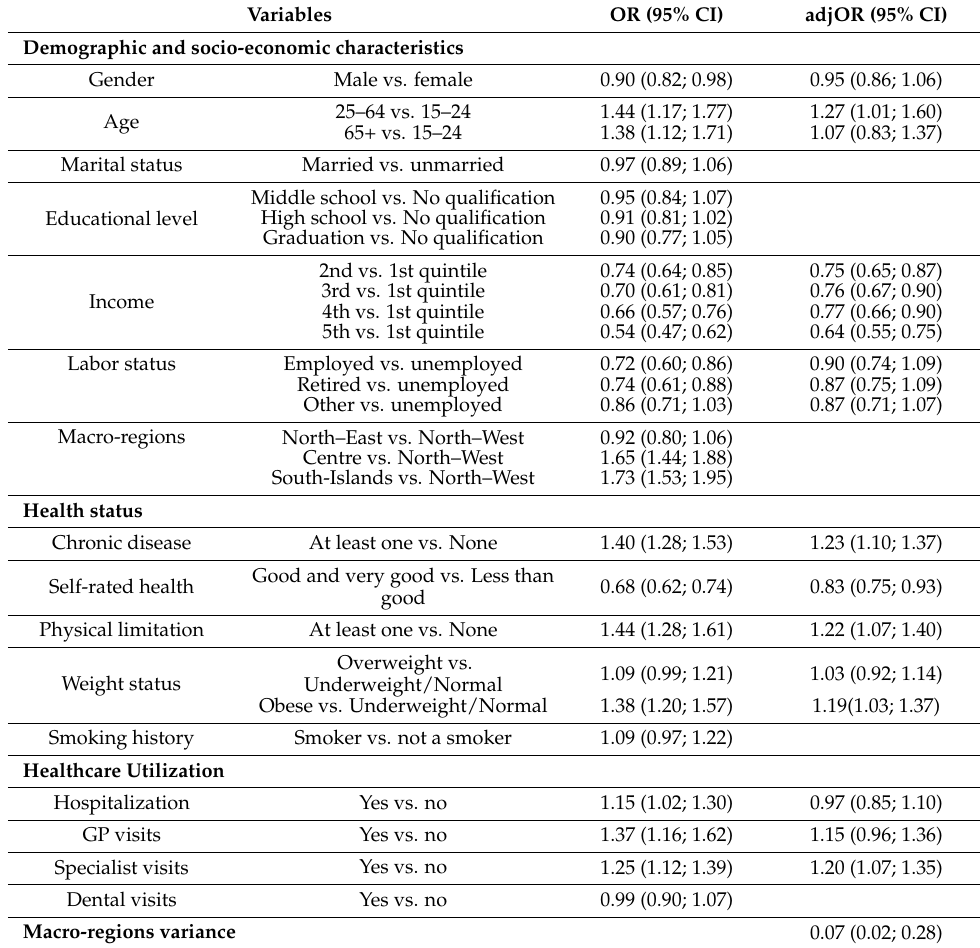
Table 2. Delayed utilization due to a long waiting list related to the socio-economic and health characteristics of respondents: Univariable and multivariable